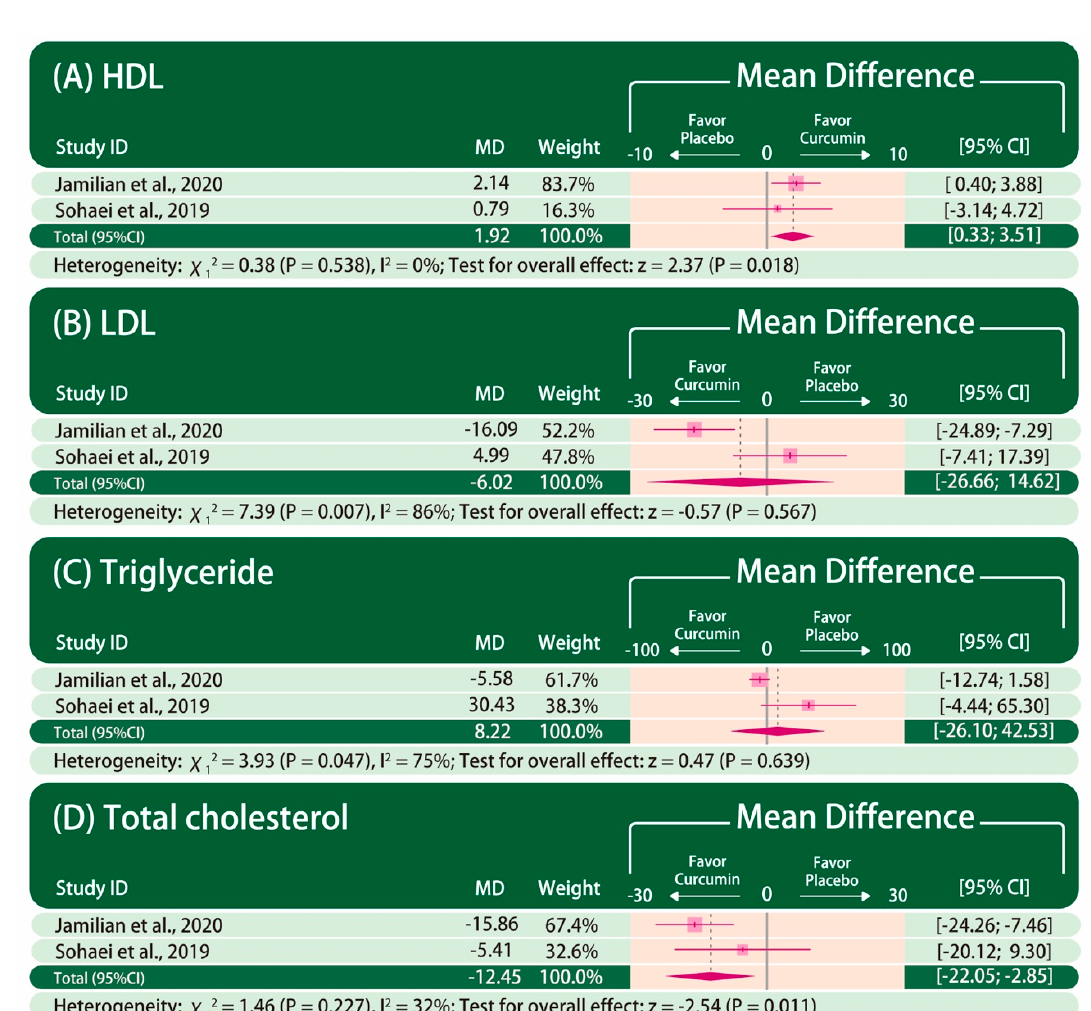
Figure 3. Forest plot of lipid profile. The mean difference between curcumin and placebo is calculated as the value in the curcumin group subtracted by that in the placebo group (curcumin–placebo). CI: confidence interval. MD: mean difference.